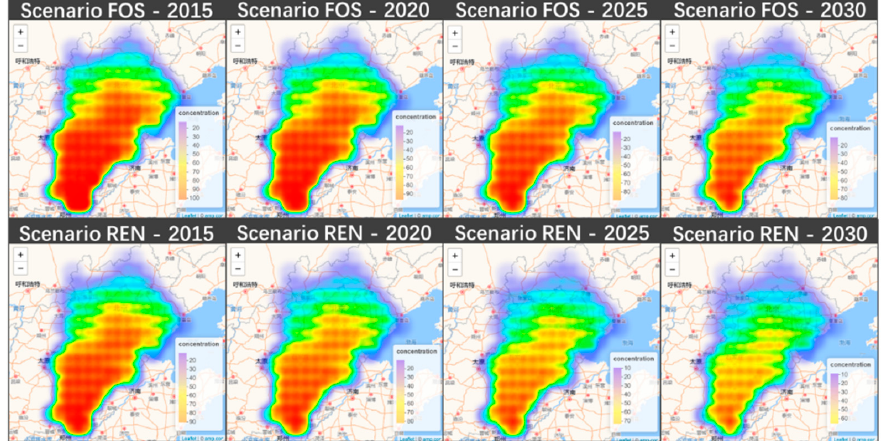
Figure 3. Annual PM 2.5 concentration distribution in two scenarios.